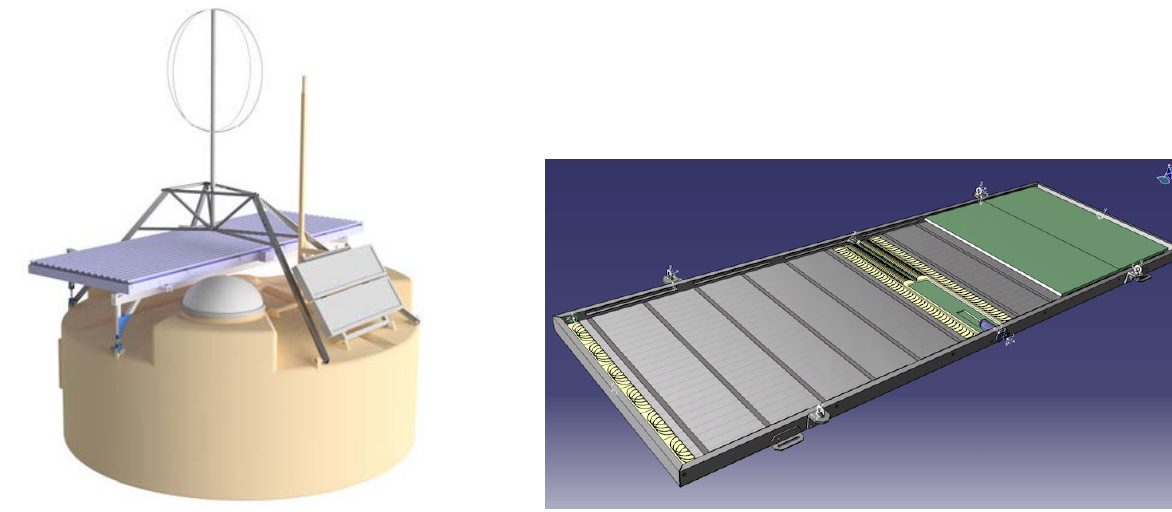
Figure 1. Left: drawing of a complete detection station for AugerPrime, with, on the WCD, a SSD module and an antenna. Right: design of one SSD